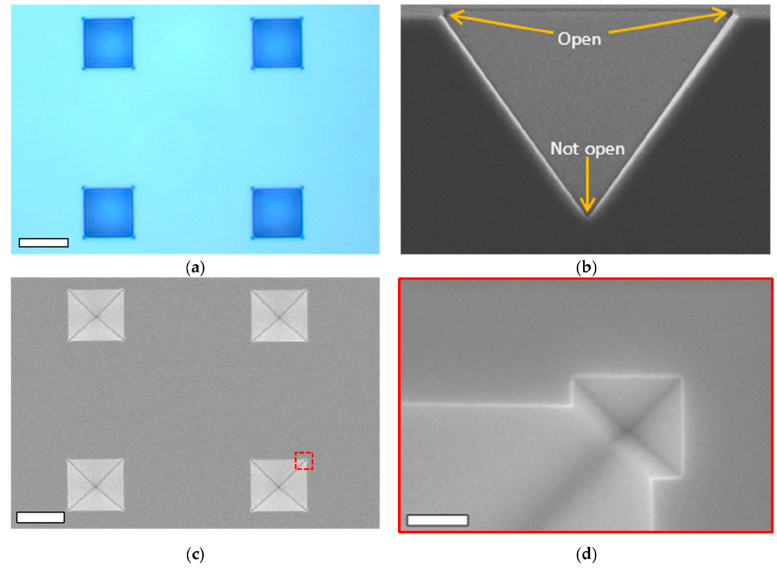
Figure 12. G2 after 5 min of etching in TMAH (25% 70 °C). ( a ) Top-view taken with an optical microscope through the SiO 2 hard-mask. ( b ) SEM image of a cross-section. ( c ) SEM image from the top after stripping the SiO 2 hard-mask in BHF. ( d ) Zoom-in SEM image of the G2 Fractal after stripping the SiO 2 hard-mask in BHF. Enlarged area is indicated in red. Scalebars: ( a , c ) 6 µm and ( d ) 200 nm.